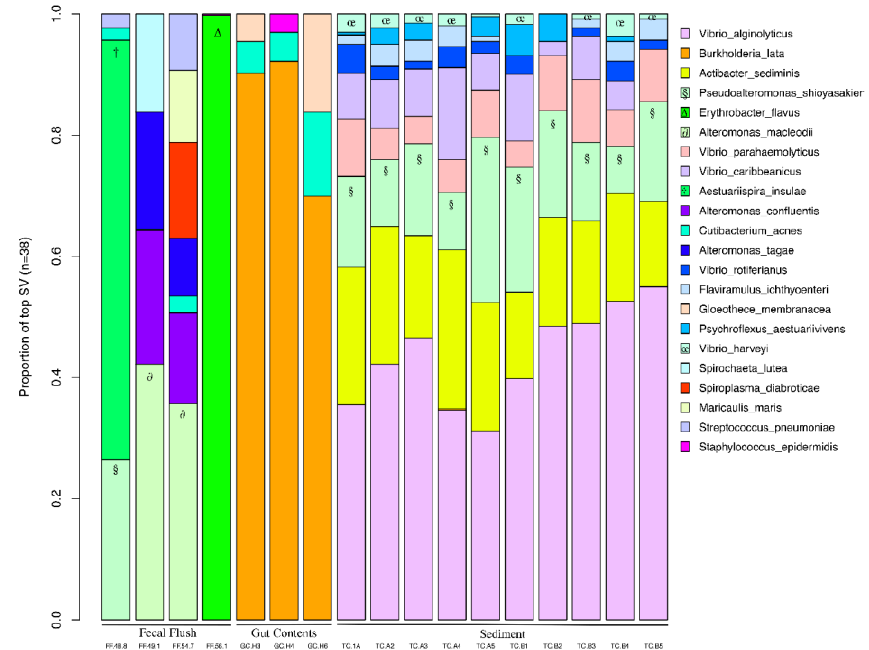
Fig. 6: Fecal flush and gut content bacterial species, shown with Tidal Creek A sediments (location where crabs were collected). FF- Fecal Flush; GC- Gut Content; TC-Tidal Creek.